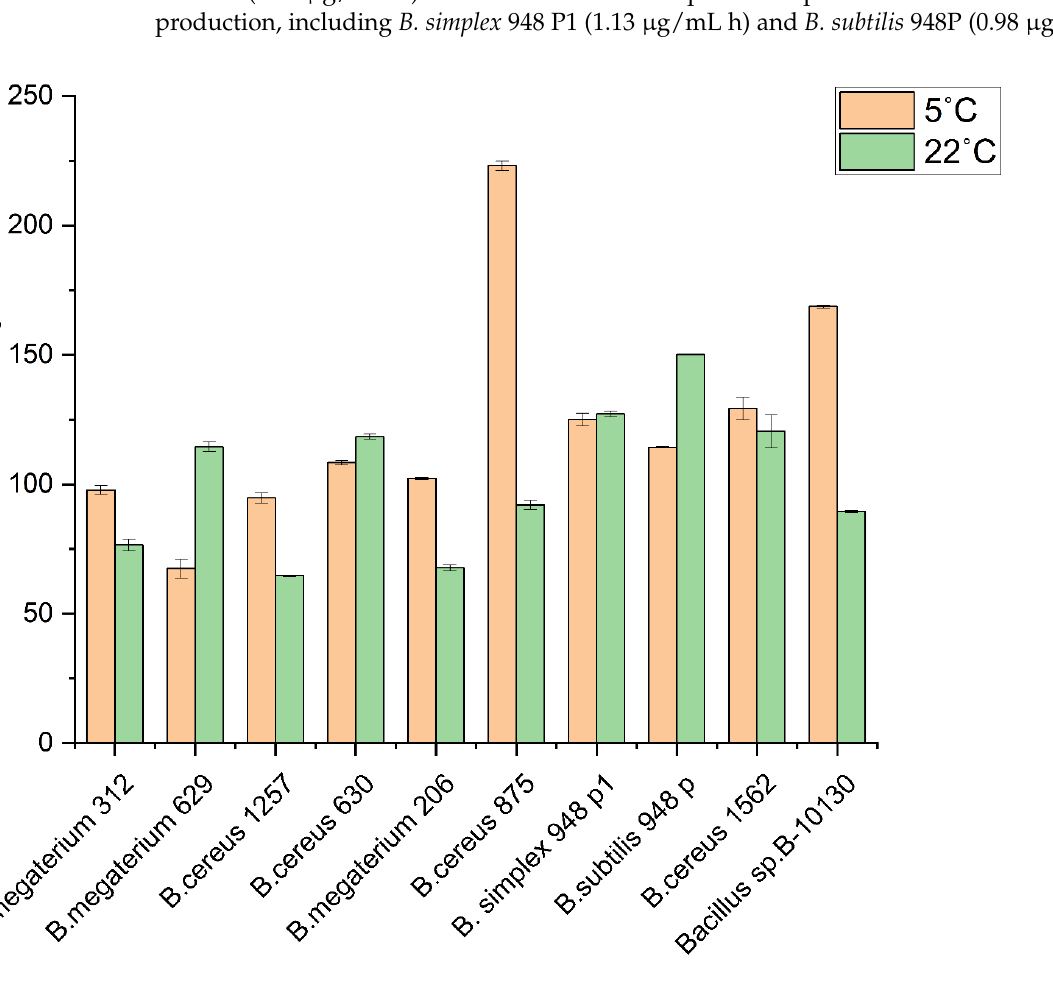
Figure 1. Influence of the cultivation temperature on the chitinolytic activity of the psychrotolerant Bacillus spp strains. The units of chitinolytic activity were converted in the enzyme, under the action of which 1 μM N -acetylglucosamine is formed within 1 h.